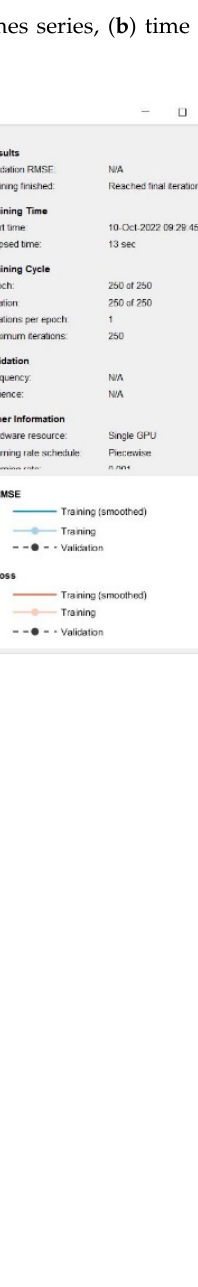
Figure 11. RMSE for chlorophyll prediction using LSTM.